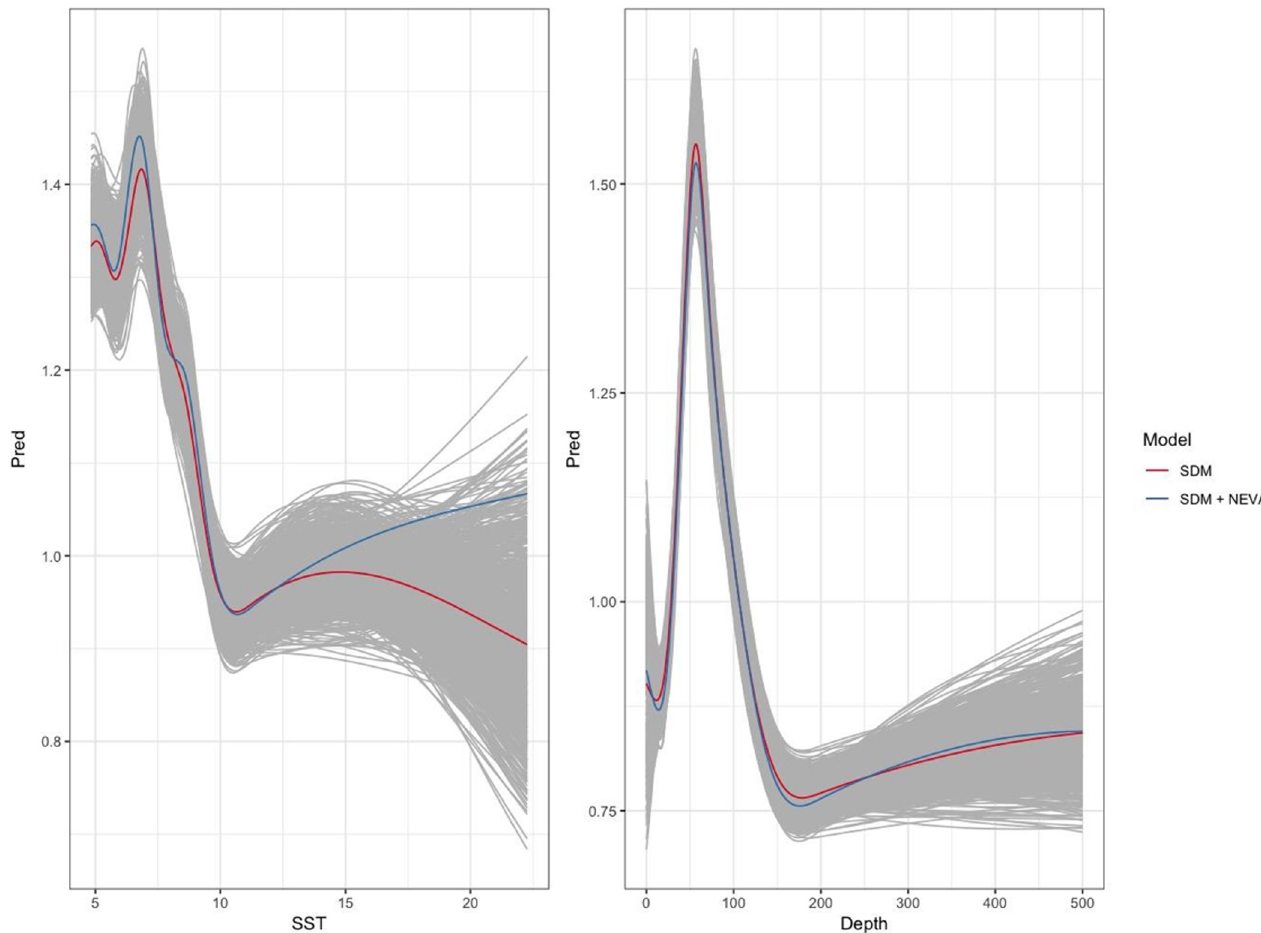
Fig 12. An example comparison between the fitted smooths selected from the combined quantitative species distribution model and qualitative expert assessment data and the fitted smooth from the quantitative species distribution model only. The plot shows predictions for Yellowtail Flounder in the Spring season. Prediction smooth plots were made from the fitted GAM logged positive biomass stage model while varying the variable of interest and holding the other variable constant at its mean. Gray lines show predictions from the suite of candidate models evaluated (n = 1000).